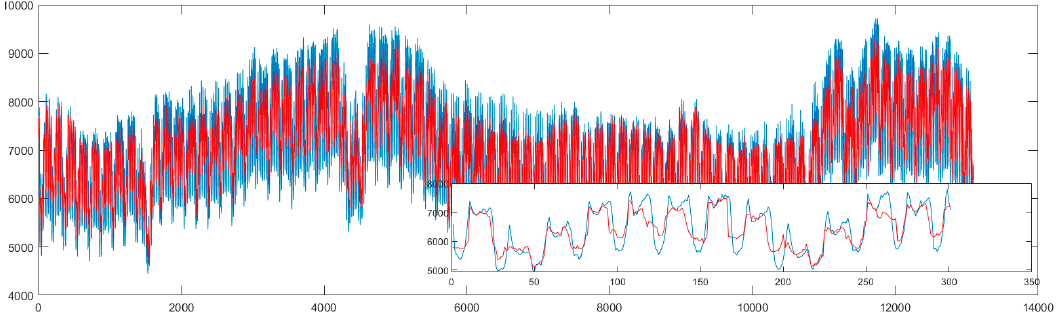
Figure 7. Prediction comparison.